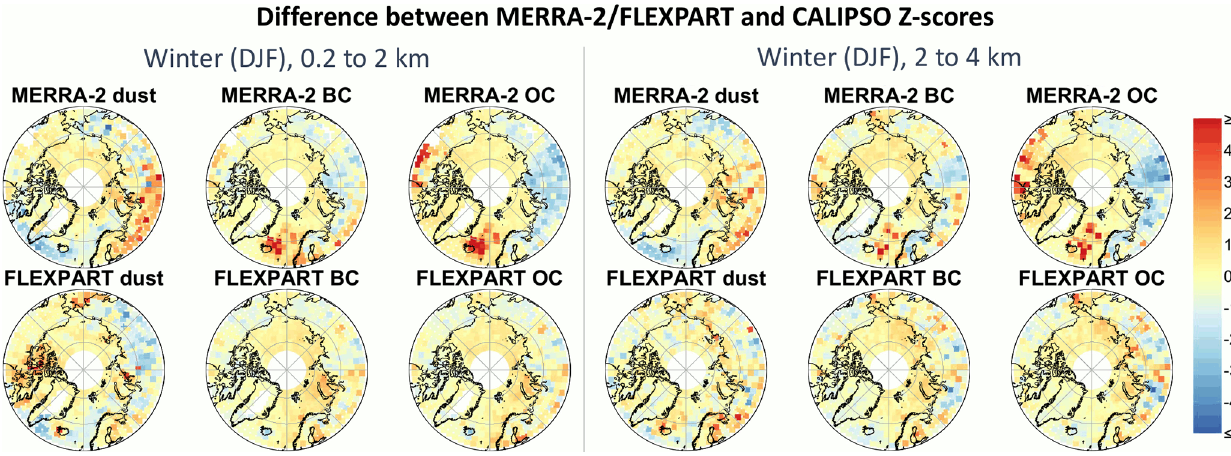
Figure 4. First (left) columns: the difference in Z scores (i.e., standard deviations from their respective means) between average MERRA- 2/FLEXPART dust concentrations and CALIPSO dust aerosol layer presence below 4km. The Z score differences are shown for nighttime winter (DJF) periods in non-diamond-dust conditions. Second and third columns: as in the left columns, except CALIPSO combustion aerosols are compared to MERRA-2/FLEXPART black carbon (BC) and organic carbon (OC) concentrations. Locations with < 30 observa- tions (white areas) are excluded in the above plots. Data from higher altitudes are shown to the right and in Fig. S4.